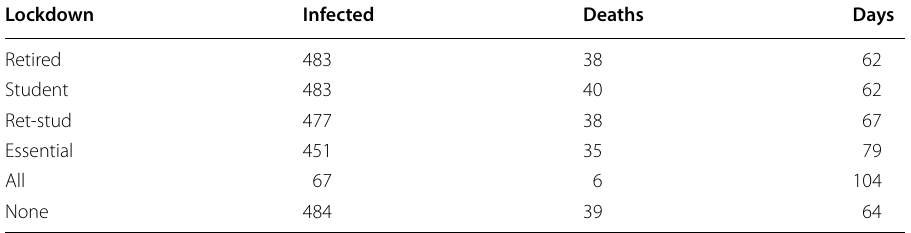
Table 5 Control, no detection and no isolation Lockdown Infected